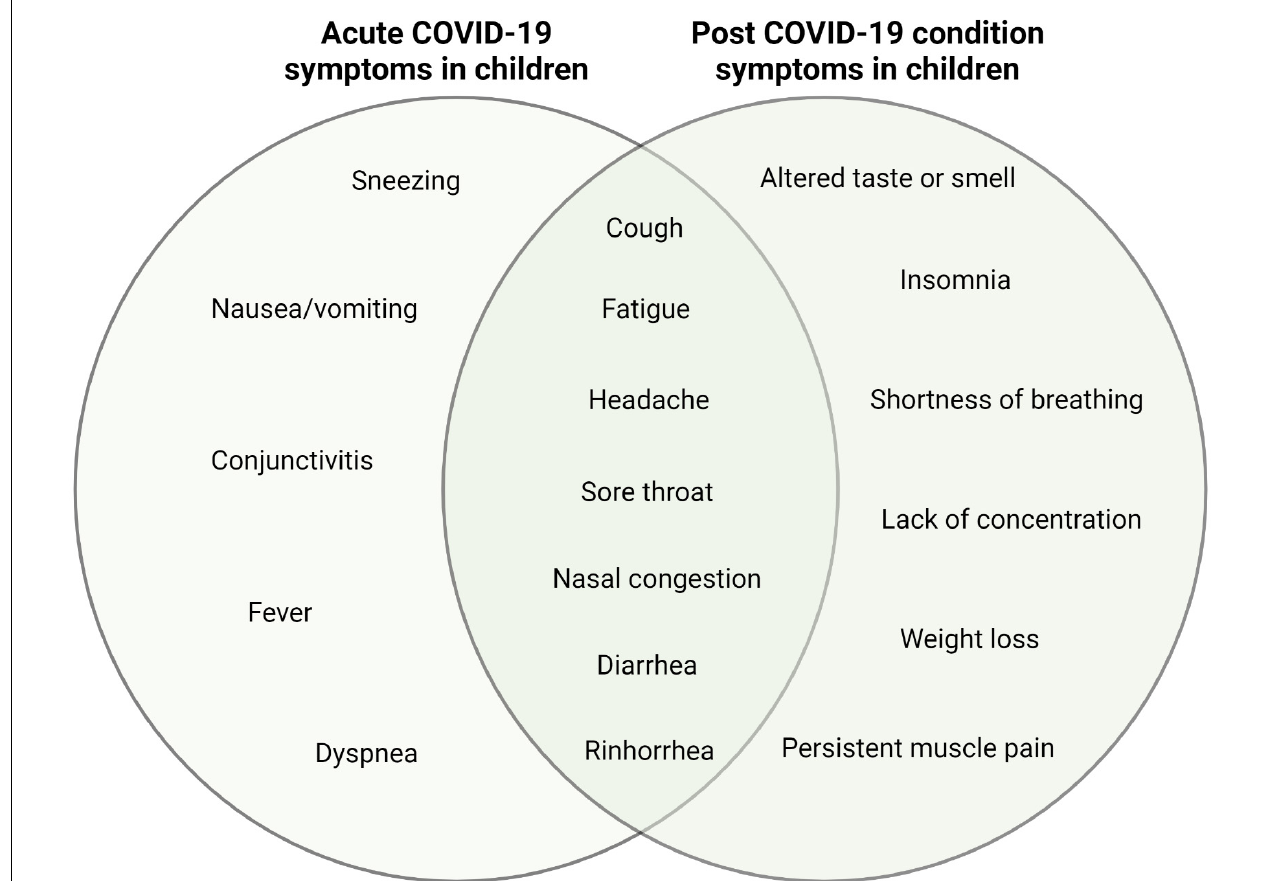
FIGURE 2 | Diagram representing specific and shared symptoms of acute and post-COVID-19 condition in children and